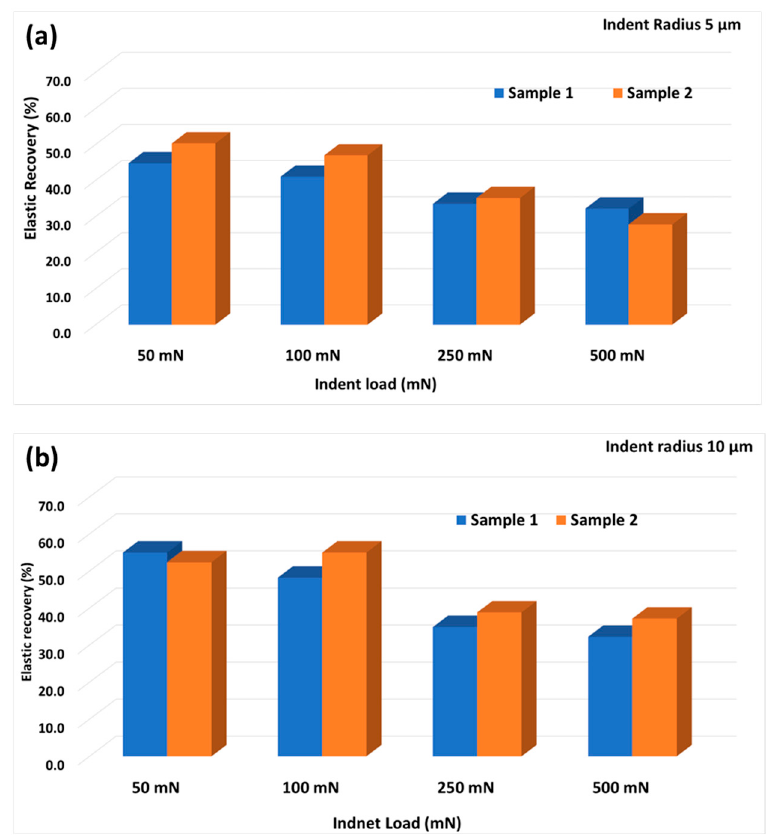
Figure 8. ( a , b ) Elastic recovery for samples 1 and 2 at indent radii of 5 and 10 µm.